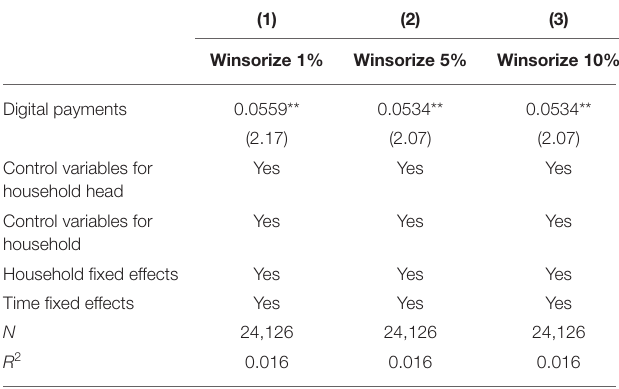
TABLE 6 | Robustness test: replacement sample range. TABLE 7 | Mechanism analysis: credit